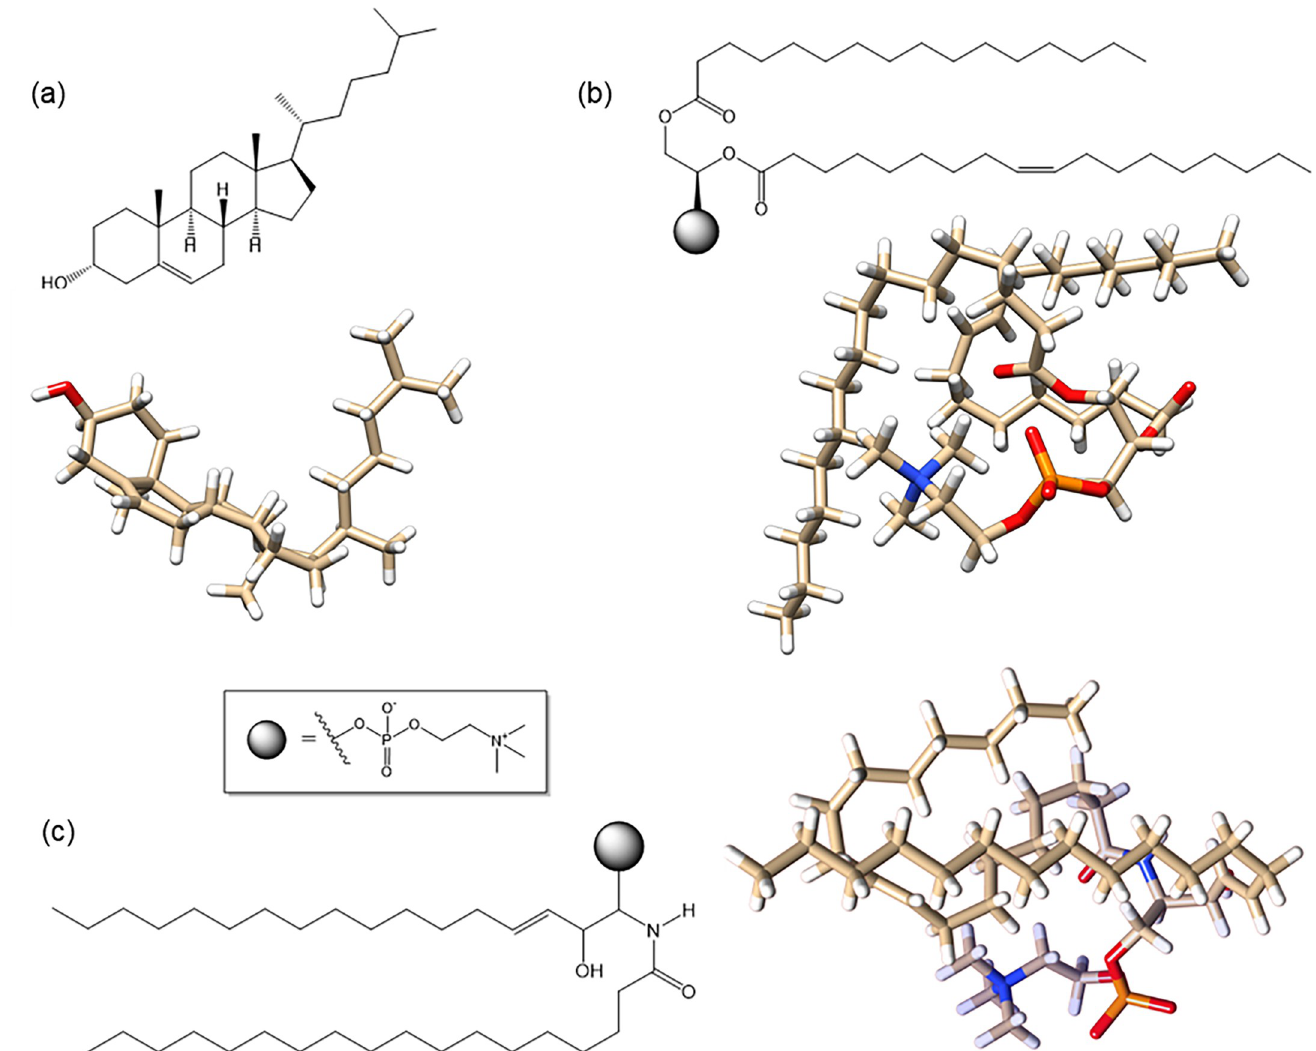
Fig 2. Molecular structures and its 3D geometric representations of (a) 3-alpha-cholesterol, (b) 1-palmitoyl-2-oleoyl-sn-glycero-3-phosphocholine, and (c) C18:1 sphingomyelin.